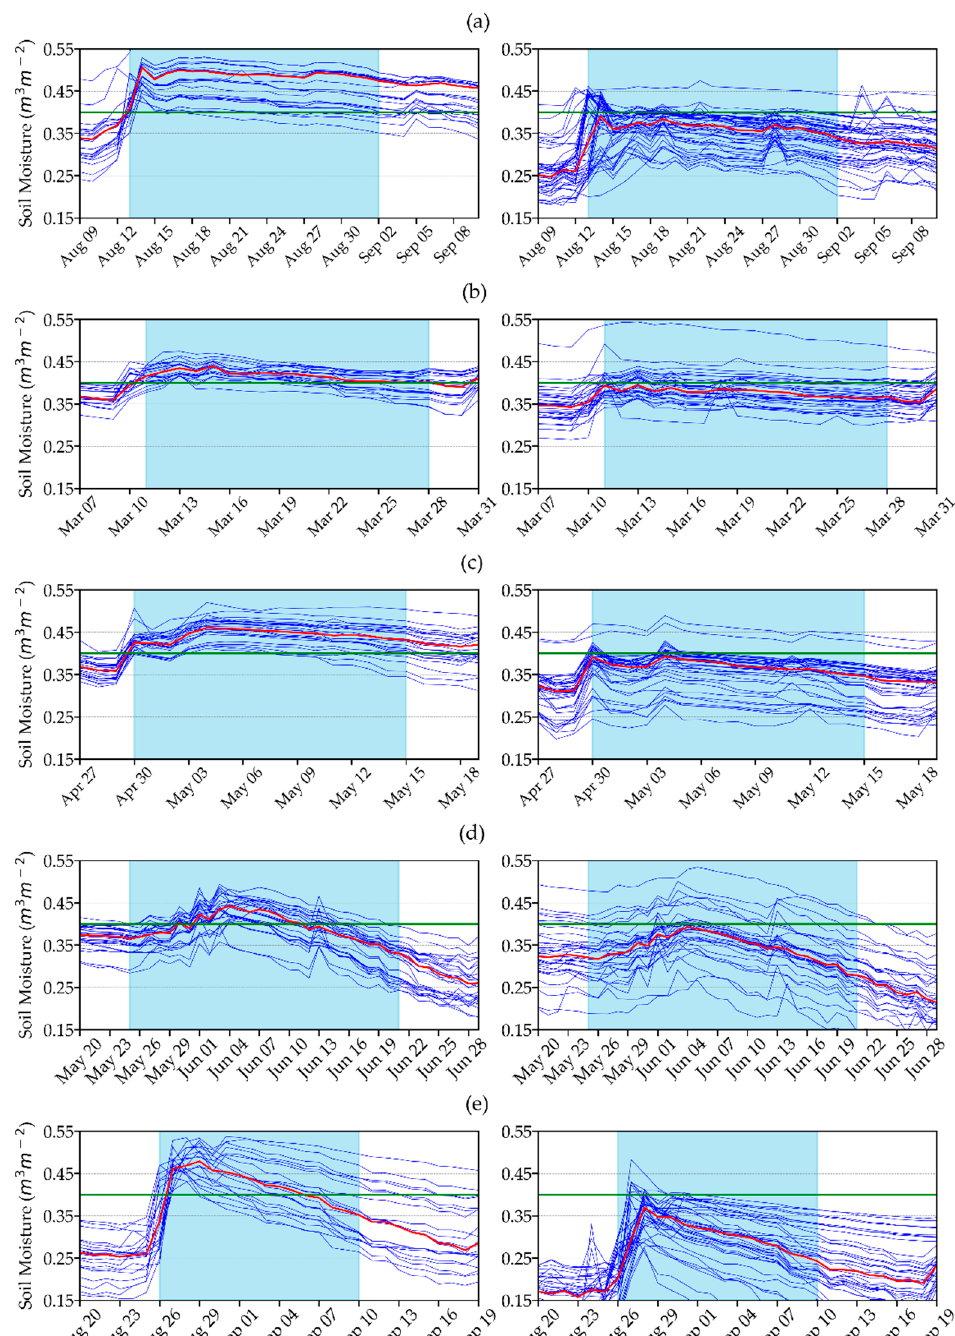
Figure 2. Surface soil moisture of sampled pixels over flooded ( left panels ) and non-flooded ( right panels ) pixels; ( a ) the Louisiana Flood (the Baton Rouge Flood), 2016, ( b ) the Mississippi Flood, 2016, ( c ) the Missouri Flood, 2017, ( d ) the Texas Flood, May 2016, ( e ) the Hurricane Harvey Flood, TX 2017 (the Houston Flood). Red line indicates the median soil moisture of sampled pixels. Light blue shaded background indicates flood duration.